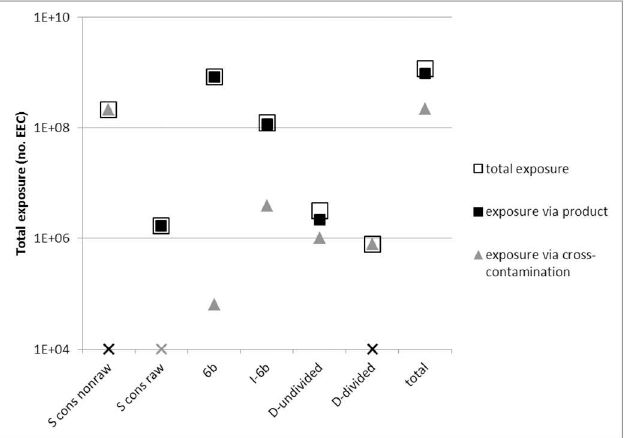
Fig 3. Total exposure and exposure split up into transmission via the meat product and cross- contamination for severalproduct categories. ‘S cons non raw’ and ‘S cons raw’ stand for Surface- contaminated products (see 2.1) that were either heatedor not heated by the consumer, respectively. ‘6b’ and ‘I-6b’ are category 6b products and I-products without category 6b, respectively(see Table 2). ‘D-undivided’ and ‘D-divided’ refer to the fraction of Dividableproducts that were undivided and dividedby the consumer duringheating,respectively.A marker is changedto an X whileretainingblack or grey when the value is zero and is inserted arbitrarily at the Y-axis 1E+04